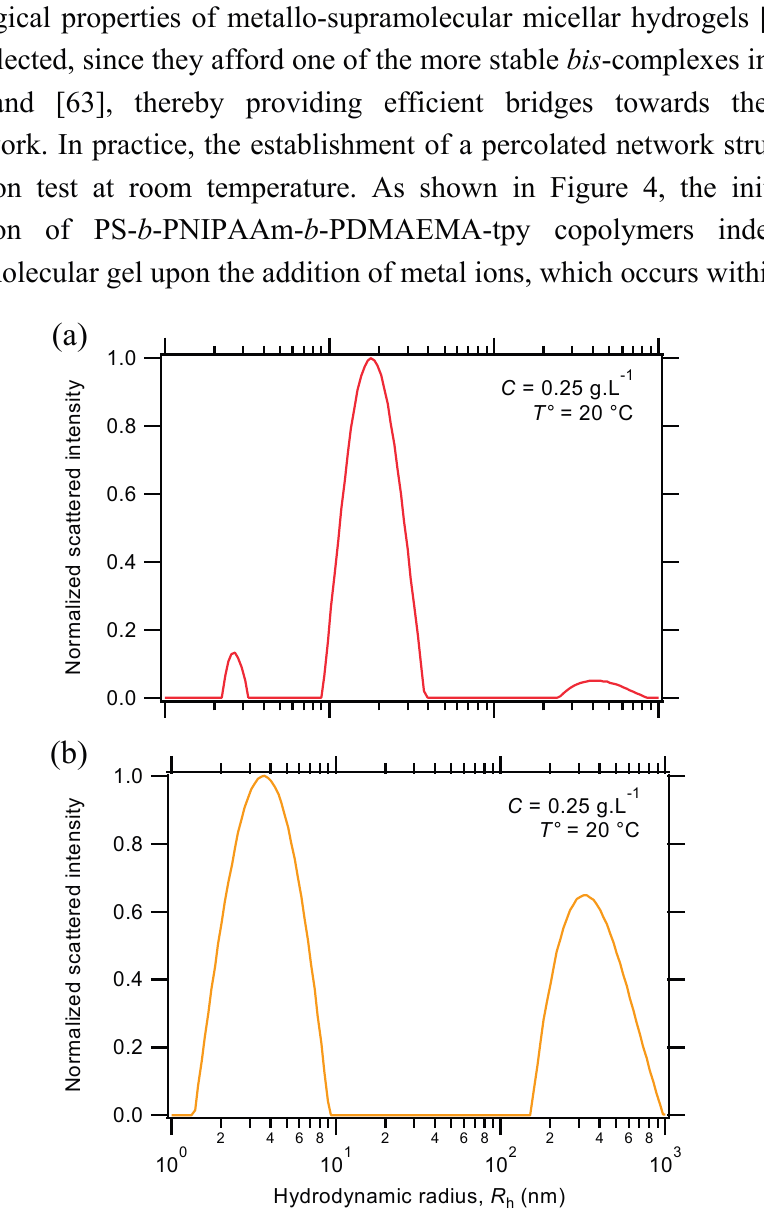
Figure 5. Distribution of hydrodynamic radii of ( a ) the PS- b -PNIPAAm- b -PDMAEMA-tpy triblock terpolymer and ( b ) the parent PNIPAAm- b -PDMAEMA-tpy diblock copolymer in aqueous